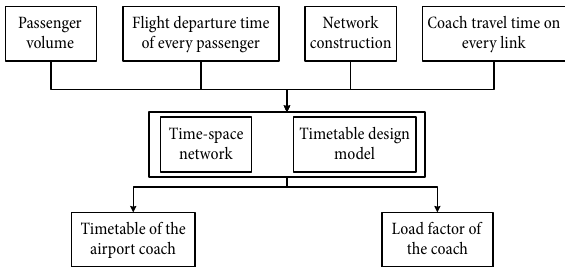
Fig. 4. The inputs and outputs of the